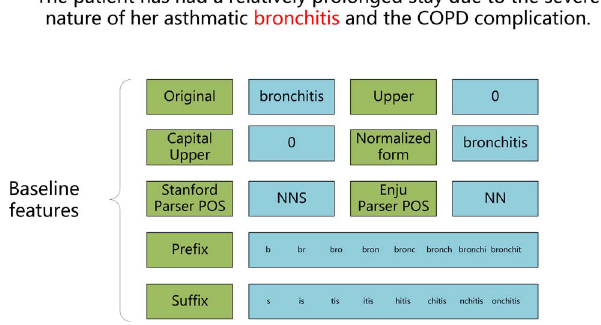
Figure 3. Detailed explanation of baseline features. doi:10.1371/journal.pone.0108396.g003 PLOS ONE |